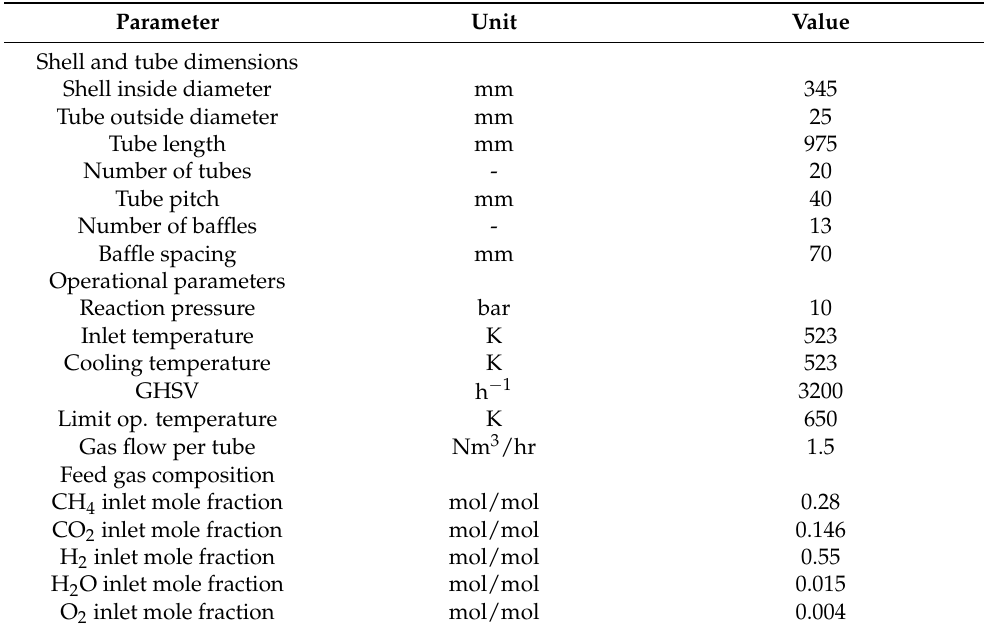
Table 2. Design and operational parameters for simulated multi-tubular fixed-bed reactor. Biogas composition from